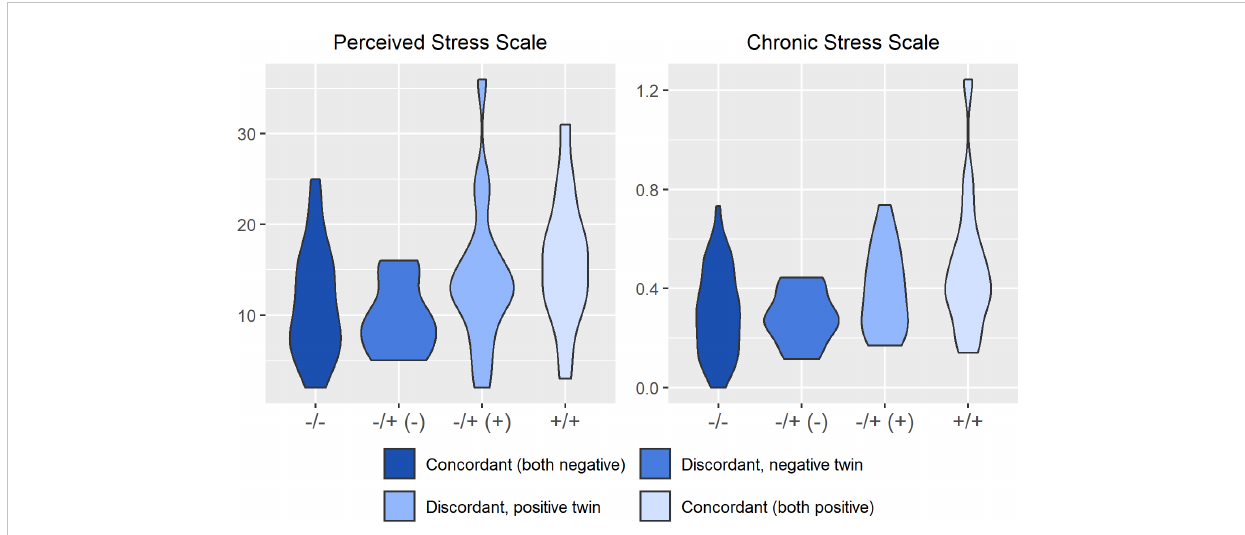
FIGURE 4 Distribution of psychosocial stress arrayed by twin concordance for lifetime history of Major Depression (MD). Distribution of stress indicators (Perceived Stress Scale and Chronic Stress Scale) by twin concordance for MD as assessed by the Diagnostic Interview Schedule. Each plot is limited to the 42 twin pairs that were con fi rmed to be monozygotic using genetic testing. Sample size for each group shown in the legend: N Corcordant (both do not have MD) = 16 twin pairs (32 individuals), N Discordant for MD (-) = 19 twin pairs (19 individuals), N Discordant for MD (+) = 19 twin pairs (19 individuals), and N Corcordant (both have MD) = 7 twin pairs (14